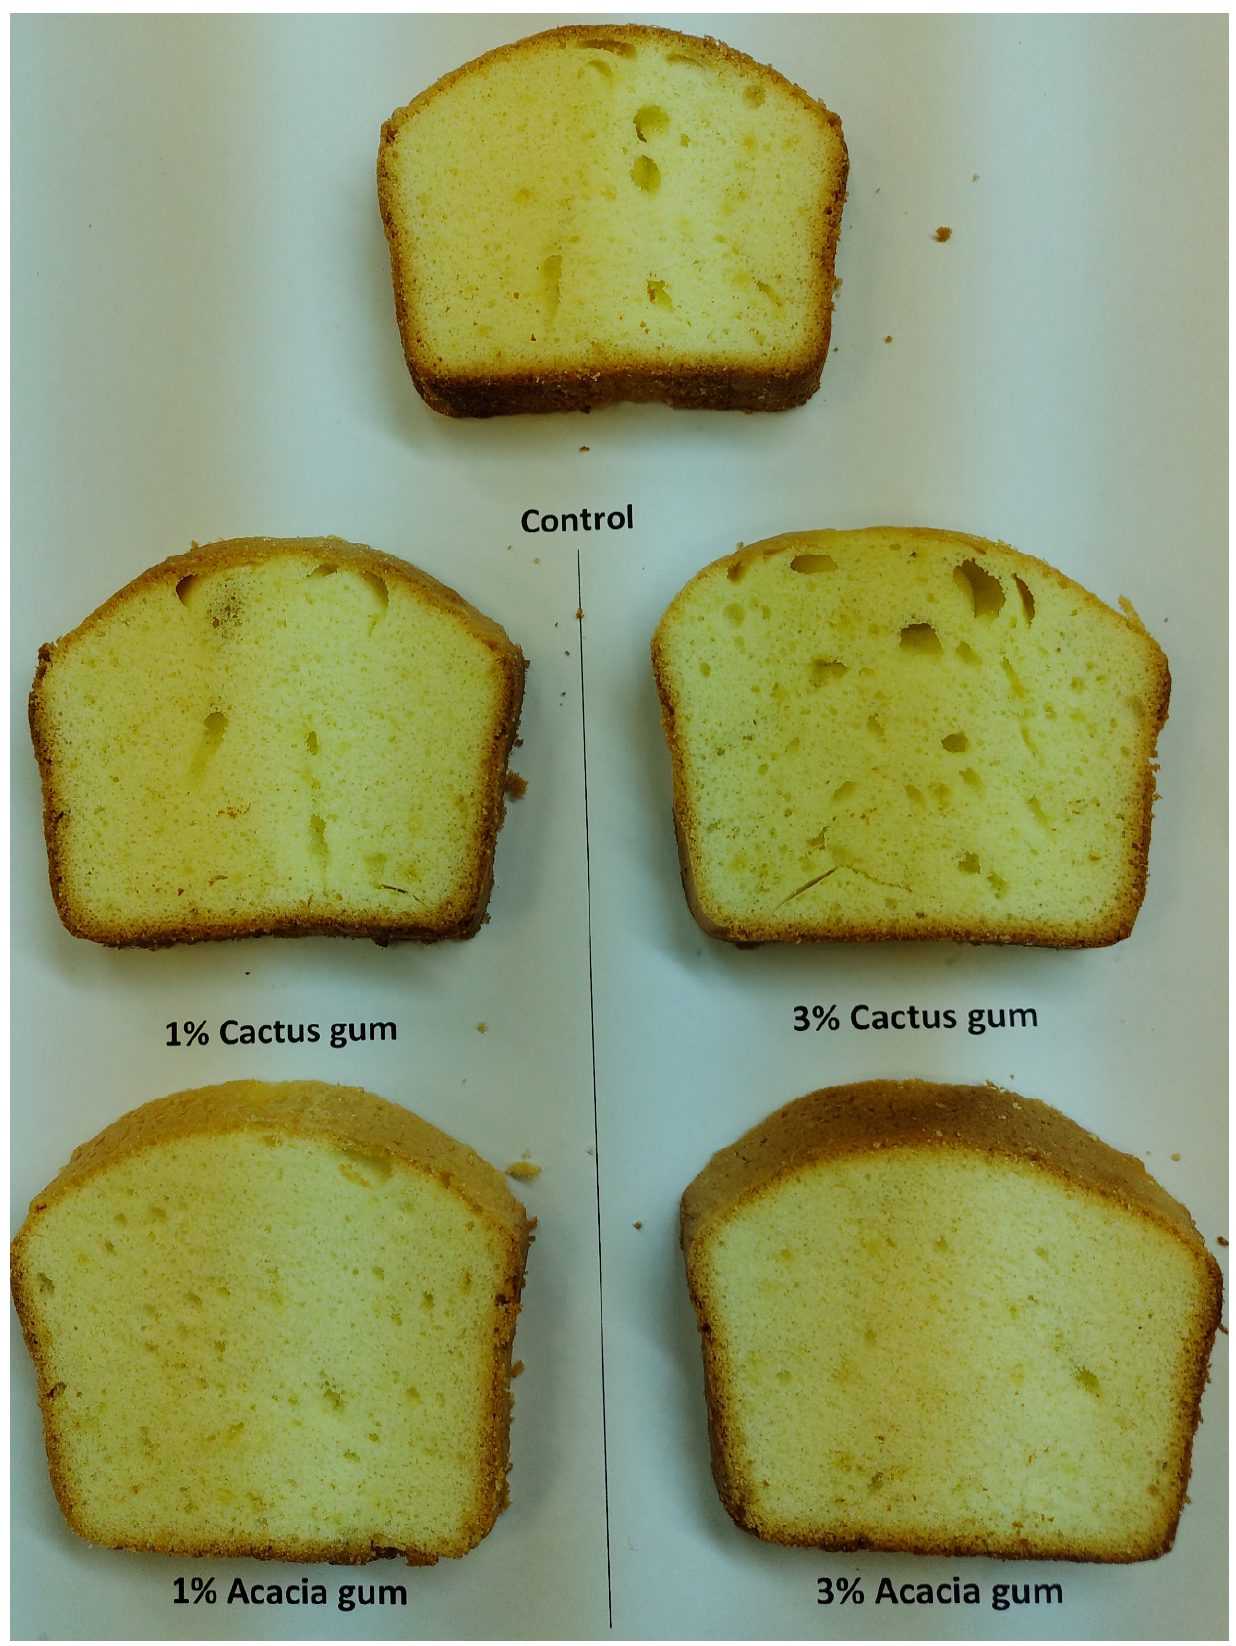
Figure 3. Images of the cake loaves containing acacia and cactus gums.